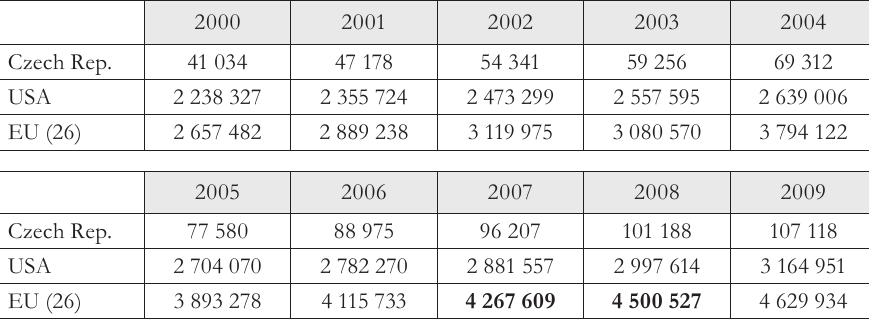
Tab. 1 - Development of the number of tertiary education of graduates for the period 2000-2009. Source: (Eurostat, 2013a), own